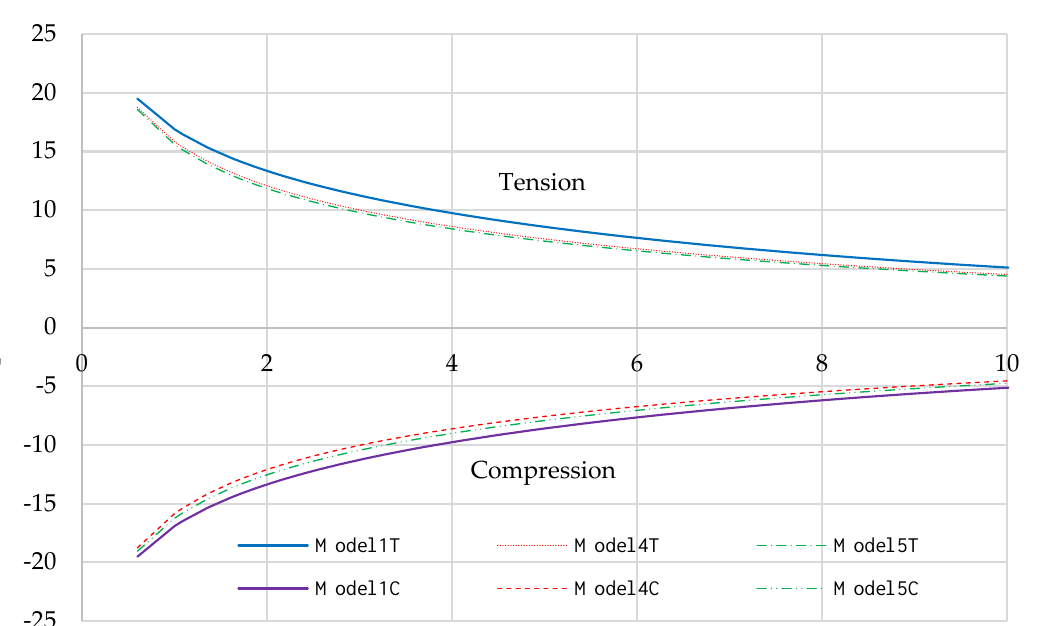
Figure 10. Shear stress versus pile–soil relative displacement.